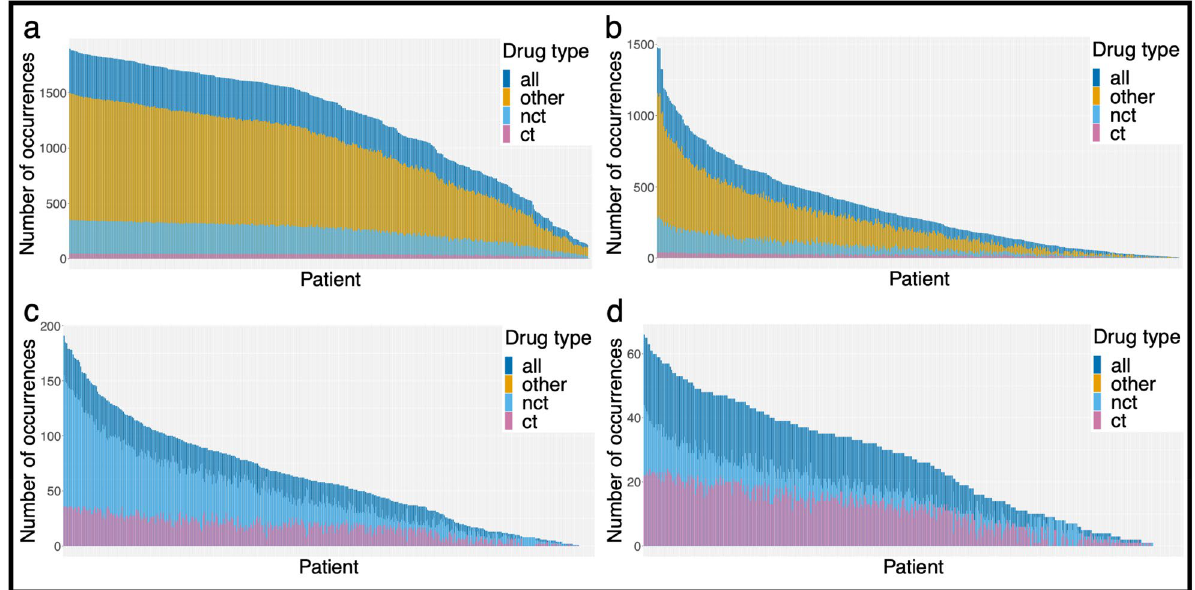
Figure 3. Development of the “drug load” along the filtering process. Each bar depicts a “drug load” per patient. Bars are not stacked, but overlying. Note that the y-axes change throughout the filtering. Drugs tested in bladder cancer trials or trials generally including solid tumors (ct) were distinguished from drugs used in general cancer trials (nct) and from medications not related to cancer in general. Purple bars illustrate the total drug load per sample. Drugs with no reference to cancer therapy are illustrated in yellow (other). ( a ) Barplot illustrates the “drug load” for all SNVs and CNVs after querying DGIdb before any filters were applied. In ( b ) “drug load” after filtering for clinically relevant variants is depicted. In ( c ) cohort prevalence filters for variants were applied and drugs with no reference to cancer therapy were excluded. ( d ) Barplot illustrates the final “drug load” for curated drug-gene interactions after integration of CIViC and manual curation results. (R Core Team (2019). R: A language and environment for statistical computing. R Foundation for Statistical Computing, Vienna, Austria. https ://www.R-proje ct.org/) 57 .